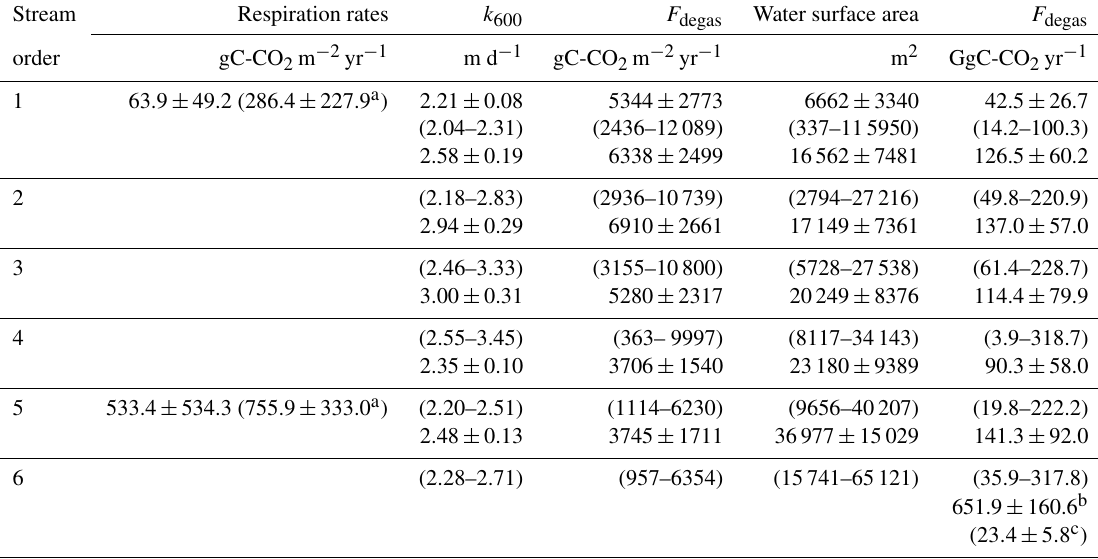
Table 6. At the Nyong watershed scale, yearly averages with standard deviations (based on averaging monthly values in each stream order) of CO 2 degassing rates ( F degas in gC-CO 2 m − 2 yr − 1 ) , k 600 (md − 1 ) , water surface area (m 2 ) and integrated CO 2 degassing flux ( F degas in GgC-CO 2 yr − 1 ) , estimated in the different stream orders. Range (based on monthly values) is shown between brackets. In addition, rates of